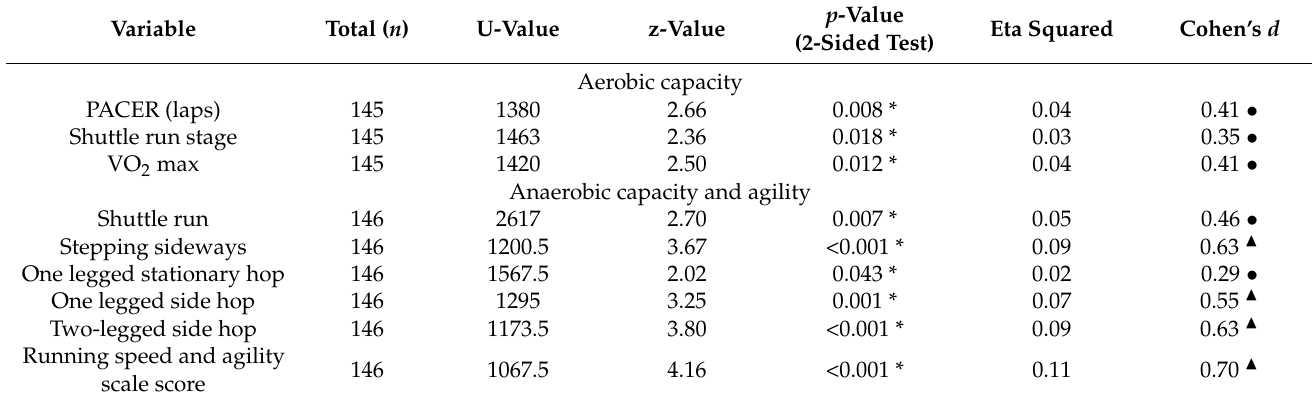
Table 2. Statistics for the comparison between motor proficiency groups on health-related fitness (aerobic, anaerobic capacity and agility, strength and muscular endurance, and body